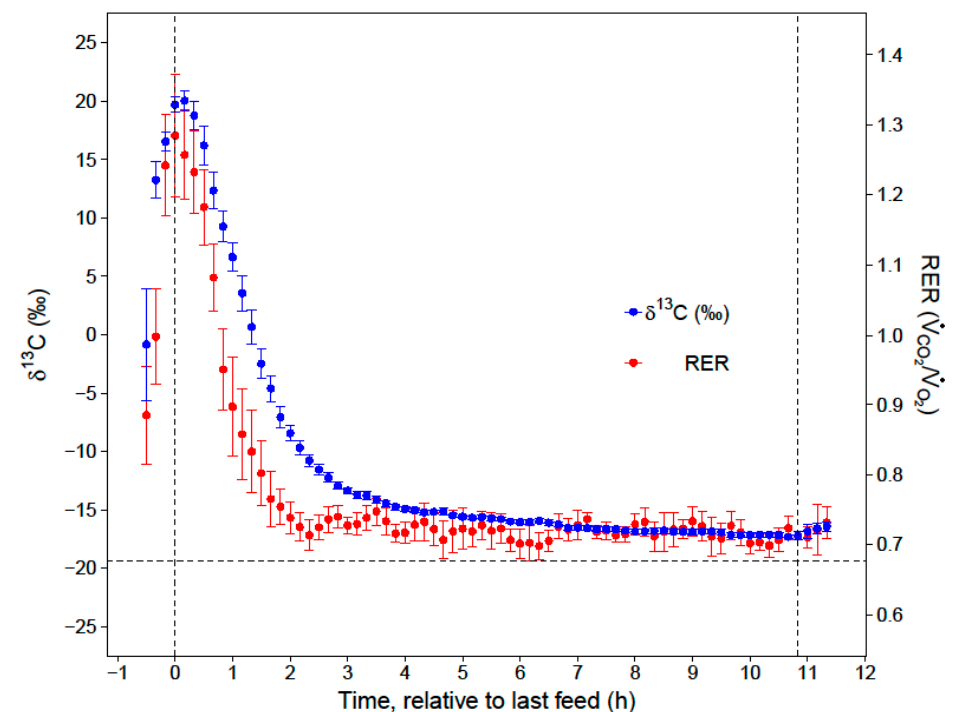
Figure 2. Overnight 13 C signature ( δ 13 C ‰ ; blue) and RER (red) of fed trials exhibited by ruby-throated hummingbirds, relative to the time of the last feeding (time = 0), which was, on average, 10 min prior to lights out. The horizonal dashed line indicates the average nighttime 13 C signature and RER in fasted trials. Vertical dashed lines indicate time of lights off and on. Data are presented as mean ± SEM of 10-min bins averaged across the individual birds (n = 6).